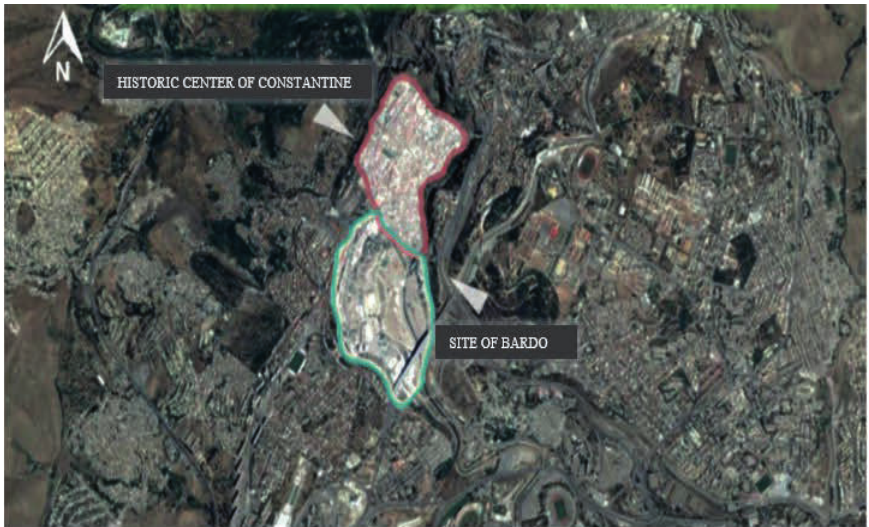
Fig. 3. Situation of Bardo Park in Constantine city centre (Google Earth 2021, authors’